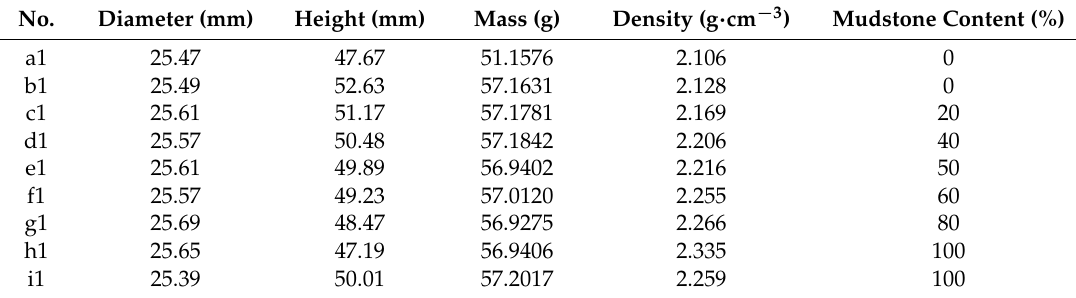
Table 2. Physical parameters of mixed specimens.